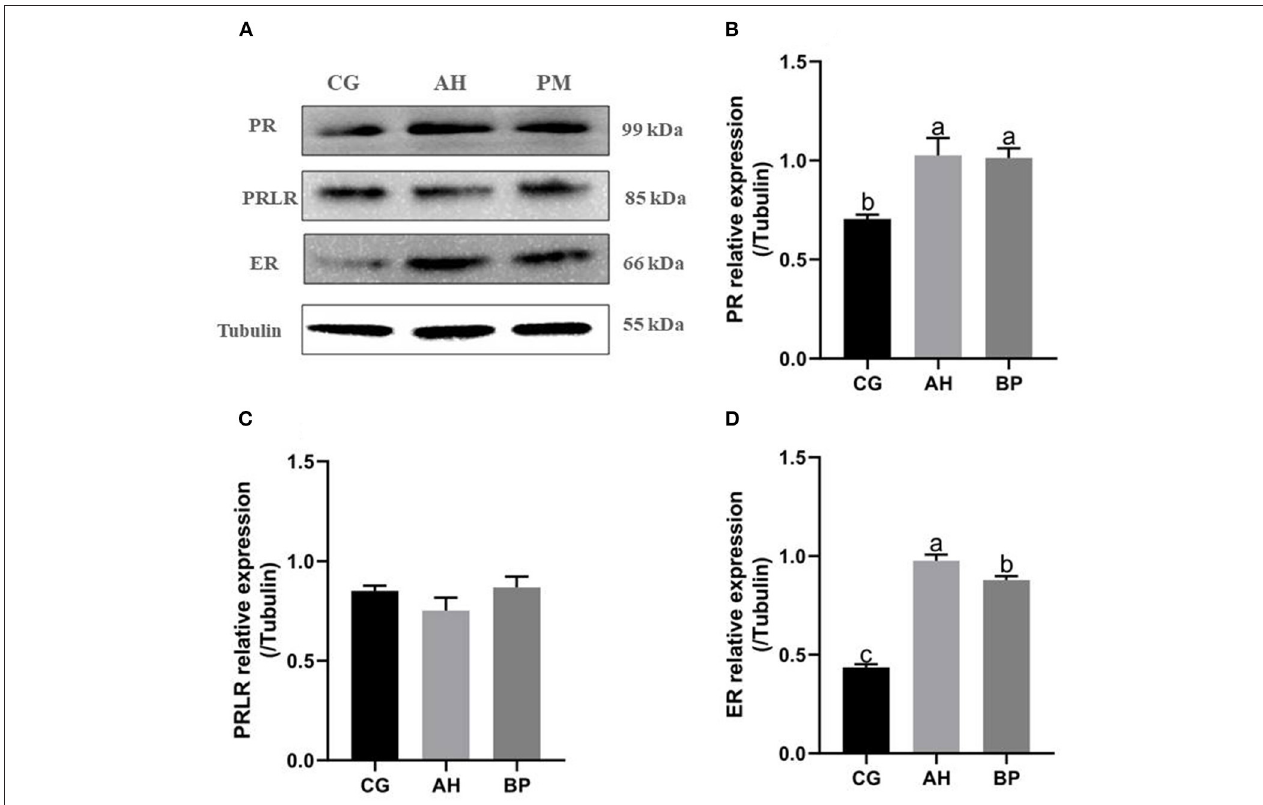
FIGURE 7 | Effect of alfalfa flavone and hybrid Broussonetia papyrifera flavone on the expression of hormone receptor protein in gMECs. (A) The level of the PR, PRLR, and ER proteins expression in gMECs; (B) Protein expression of PR; (C) Protein expression of PRLR; (D) Protein expression of ER. Mean values without common superscript (a and b) differ significantly among CG, AH, and BP groups ( p < 0.05). The c value indicates the mRNA level of SREBP in the BP group was significantly higher than that in the CG and AH groups, and the mRNA level of SREBP in the AH group was significantly higher than that in the CG group.